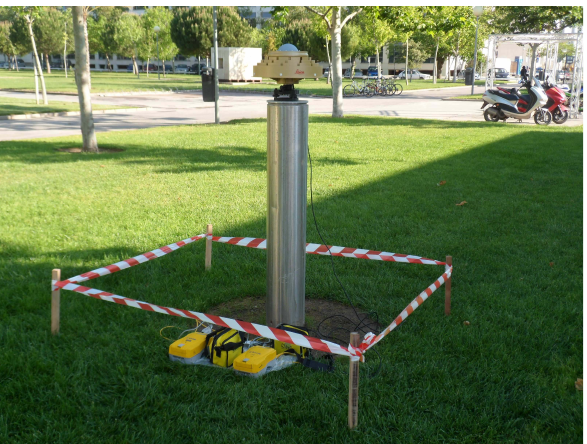
Figure 1. Global Navigation Satellite System (GNSS) measurement at the Universitat Politècnica de València (UPV) calibration baseline using a 3D choke-ring antenna equipped with a signal splitter and two receivers collecting the same